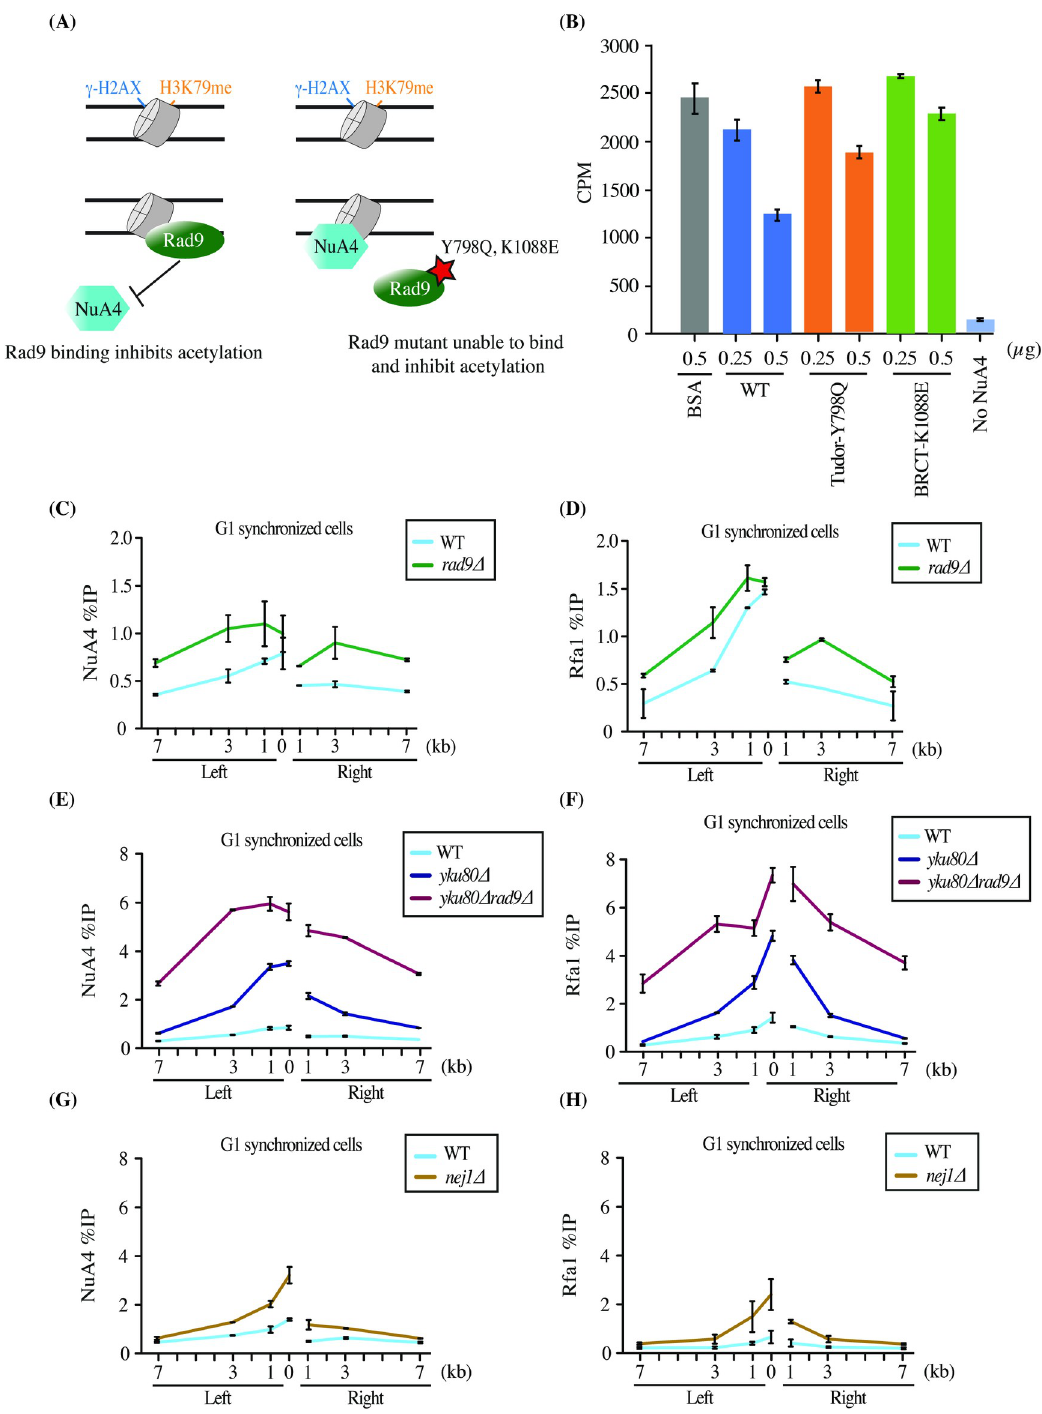
Fig 1. NHEJ factors inhibit NuA4 recruitment and end resection at a DSB in G1. (A) Schematic representation of the experiment in (B). Wild type Rad9 binds to chromatin and inhibits NuA4 from acetylating histones, whereas Rad9 mutants are unable to bind chromatin efficiently, thus resulting in acetylation of histones by NuA4. (B) In vitro HAT assay showing inhibition of NuA4 acetyltransferase activity by Rad9 using yeast native chromatin purified from MMS-treated cells and recombinant Rad9 (wild type, tudor-Y798Q and BRCT- K1088E domain mutant, S1A Fig). Recombinant Rad9 wild type and mutants were incubated with 500ng of chromatin. Afterwards NuA4 was added along with 3 H-acetyl-CoA followed by spotting on P81 membrane and scintillation counting. Error bars indicate the ranges of duplicate reactions. Only 0.5ug of WT and tudor mutant show a statistically